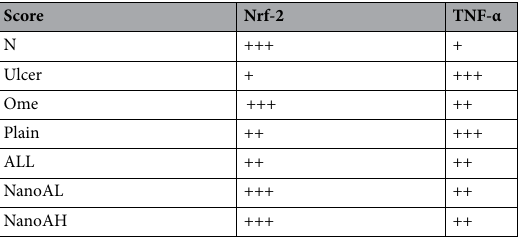
Table 6. Immunohistochemical score of gastric Nrf-2 and TNF-α. (+) weak staining, (++) moderate staining, and (+++) strong staining.